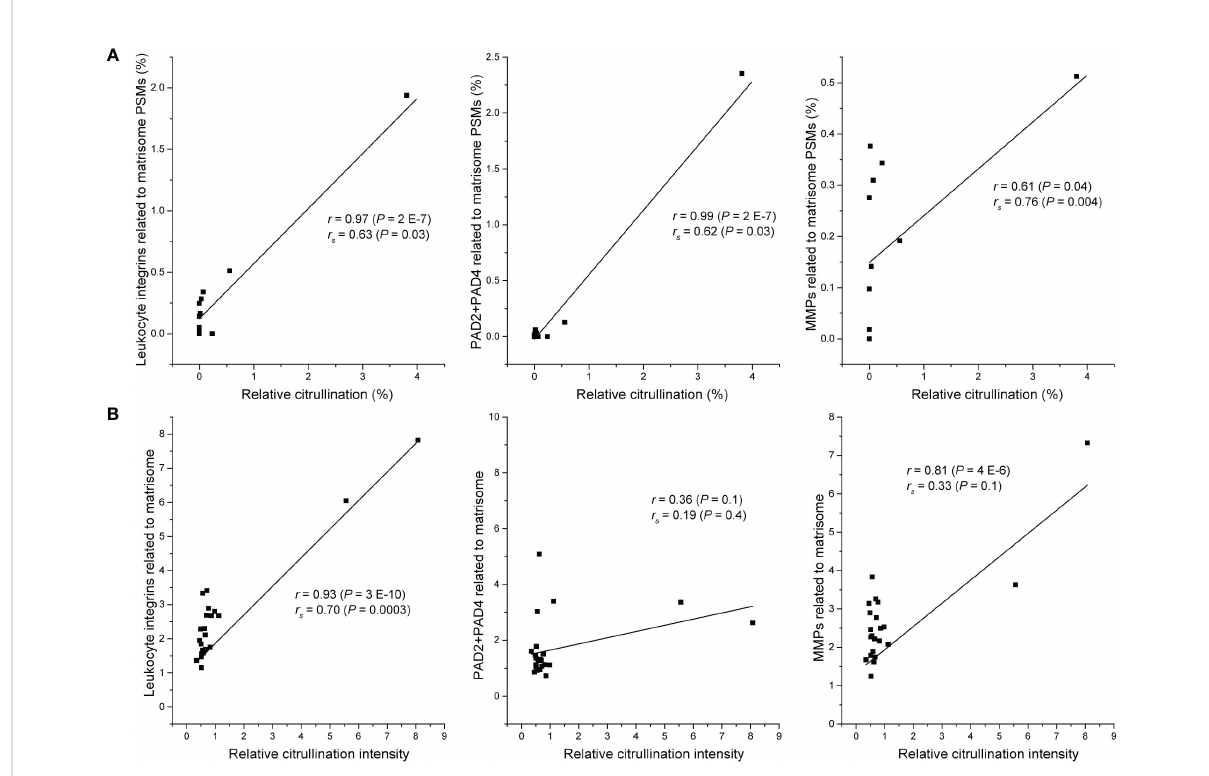
FIGURE 3 Relation between citrullination of matrisome and selected in fl ammation markers. (A) Metastatic and tumor samples of colorectal cancer patients (20). Relative citrullination was calculated by dividing the number of citrullinated matrisome PSMs with all detected matrisome PSMs in the sample (n = 12). Sum of PSMs of PAD2 and PAD4, all detected matrix metalloproteins (MMPs) or all detected leukocyte integrins (ITGAM, ITGAX, ITGB2) was divided by the number of all matrisome PSMs in the sample. (B) Subset of CPTAC colon adenocarcinoma dataset containing only tumor tissue samples (n = 22). Relative citrullination intensity was calculated by dividing median intensity of citrullinated PSMs with median intensity of matrisome PSMs in the sample. Median intensity of PSMs of PAD2 and PAD4, all detected matrix metalloproteins (MMPs) or all detected leukocyte integrins (ITGAM, ITGAX, ITGB2) was divided by the median intensity of all matrisome PSMs in the sample. r, Pearson correlation coef fi cient; r s , Spearman correlation coef fi cient; P, two-tailed P-value.